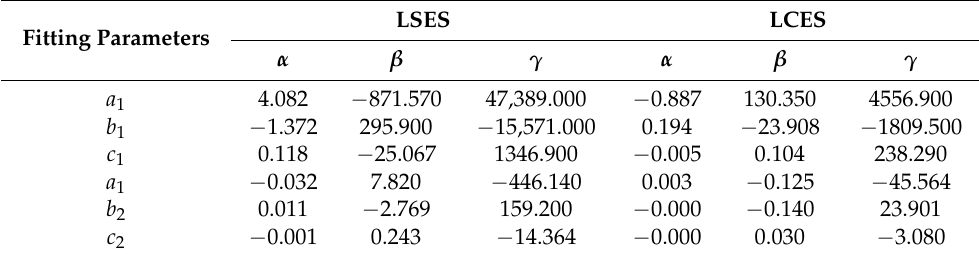
Table 2. Deduced values of α, β , and γ .